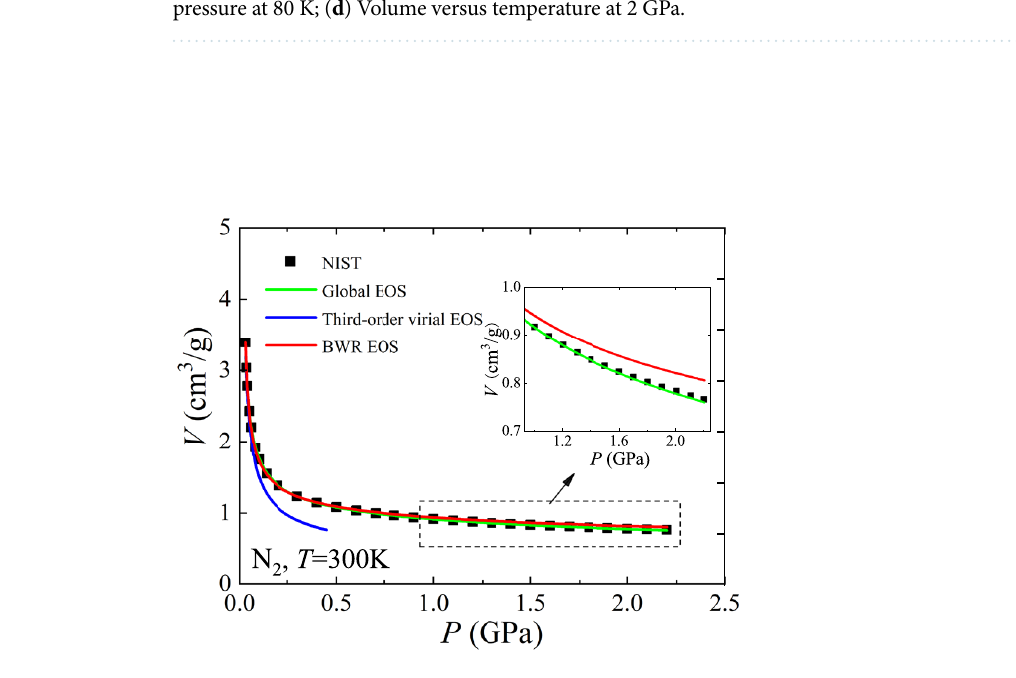
Figure 3. Comparison of the global P-V-T EOS with the third-order virial EOS and the BWR EOS using N 2